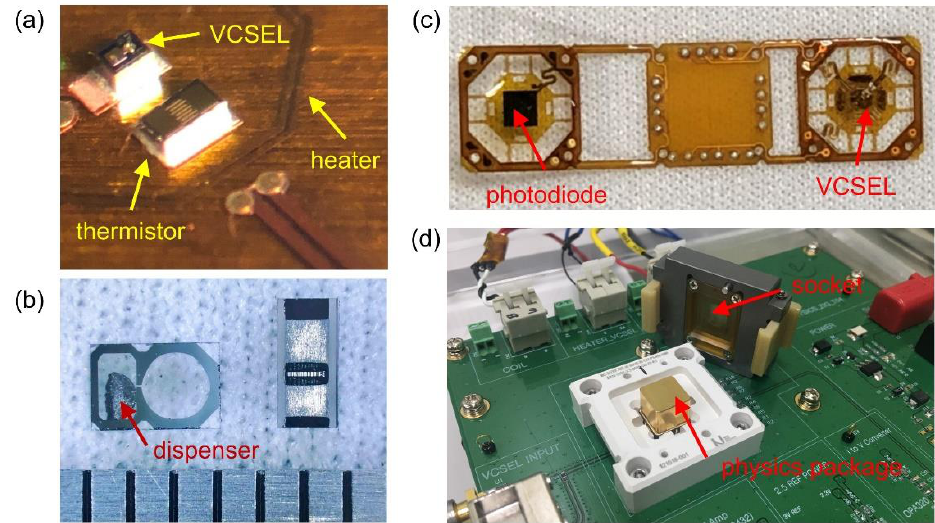
Figure 3. ( a ) Optical image of the substrate on which the VCSEL and the elements for temperature control are mounted. ( b ) The micro-fabricated vapor cell with a separate room for a cesium dispenser, which is activated by an infrared laser after bonding. ( c ) Flexible printed circuit board frame holding polyimide suspensions. ( d ) The printed circuit board with a socket used for interfacing the signal from the physics package.